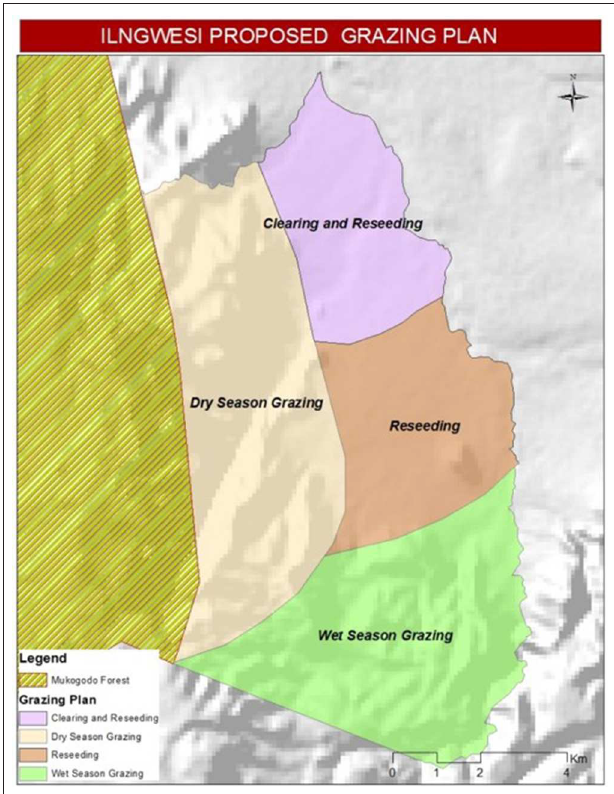
FIGURE 9 | Proposed revised grazing plan for Il Ngwesi